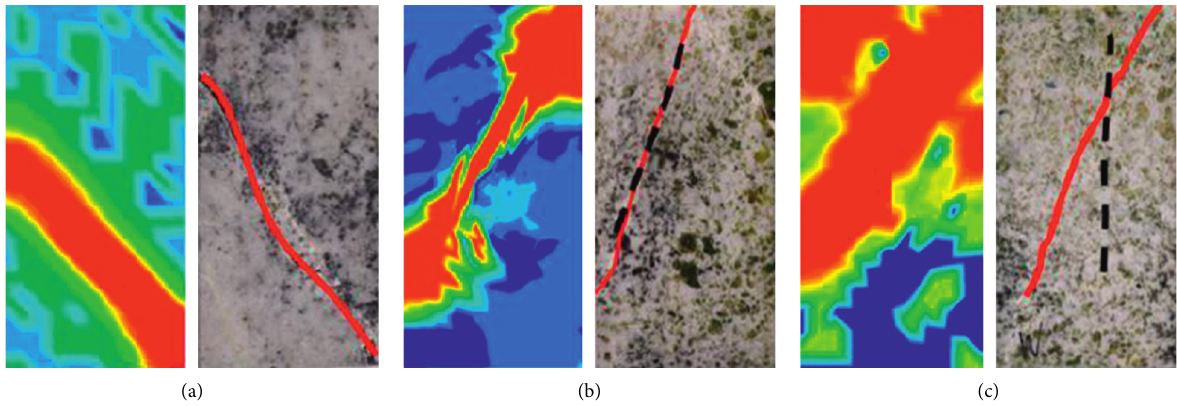
Figure 11: Comparison of experimental results and numerical simulation results.